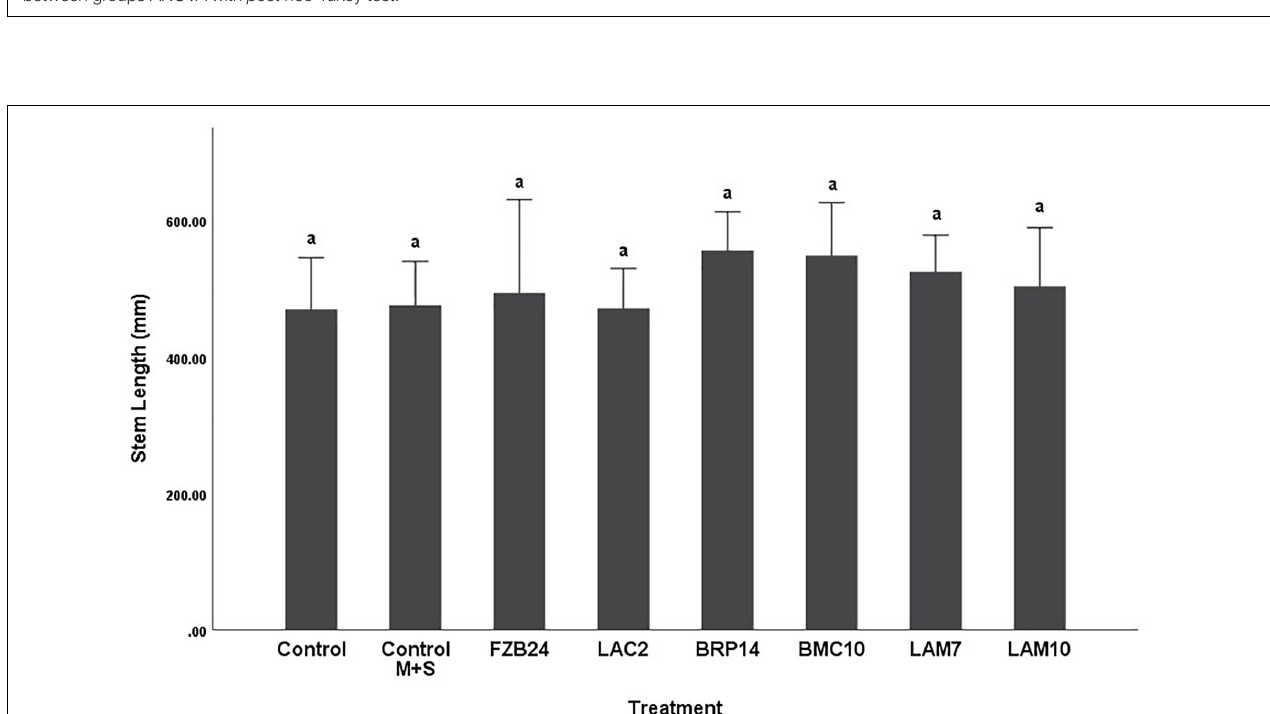
FIGURE 5 | The effect on plant stem length of BVCs from isolates growing on solid M+S media. Stem length of plants is measured in (mm), error bars represent confidence interval of the mean (99%) ( n = 8). Isolates which share a common letter are not significantly different to one another ( p > 0.01) according to one-way between groups ANOVA with post hoc Tukey